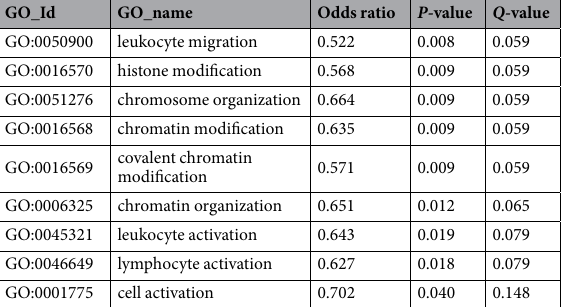
singleton clones, which reached statistical significance (Table 1). These results indicated potential drivers of clonal expansion of HIV-1-infected cells in vivo . Some expanded clones were detectable in multiple organs. Almost all previous studies on the clon- systemic or a local phenomenon, we compared the data on integration sites among different organs in a 15 wpi mice (mouse no. 5, Fig. 6A). Because of the high sensitivity of the high-throughput sequencing and analysis pipe-